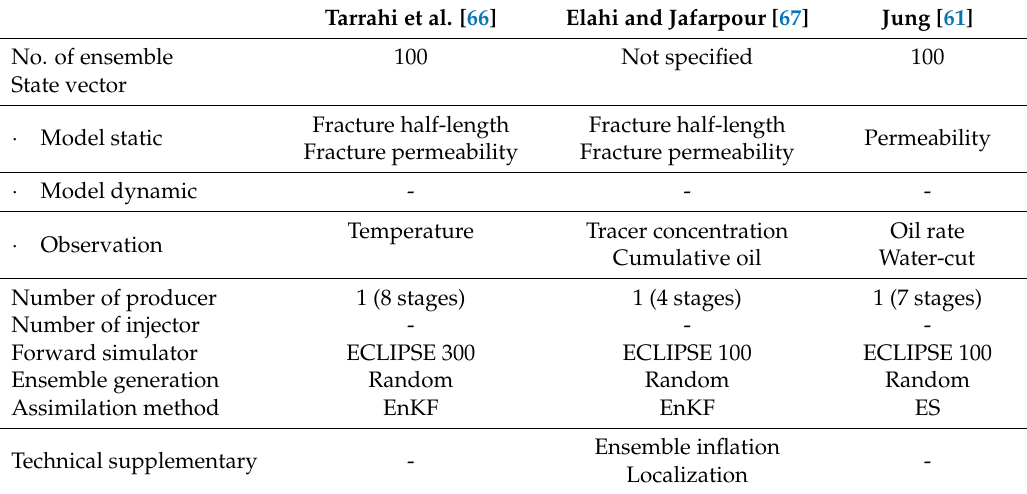
Table 4. Applications of ensemble-based data assimilation for unconventional reservoirs. Tarrahi et al.